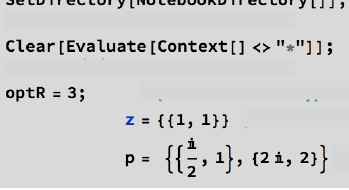
Figure 7. Part of the structure of the [SInt] algorithm corresponding to Option 3 to input r . Let us consider a general expression for the functions x + and y − (Figure